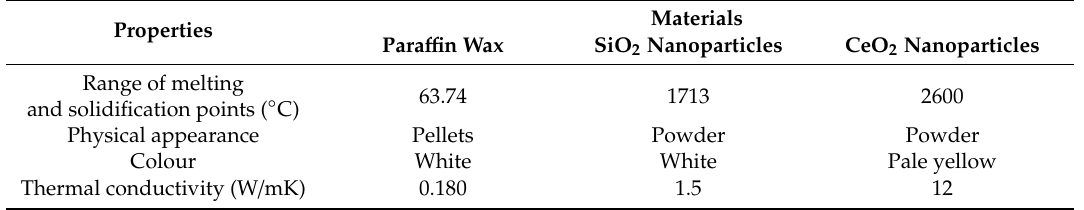
Table 1. Thermo-physical properties of experimented para ffi n and used nanoparticles.